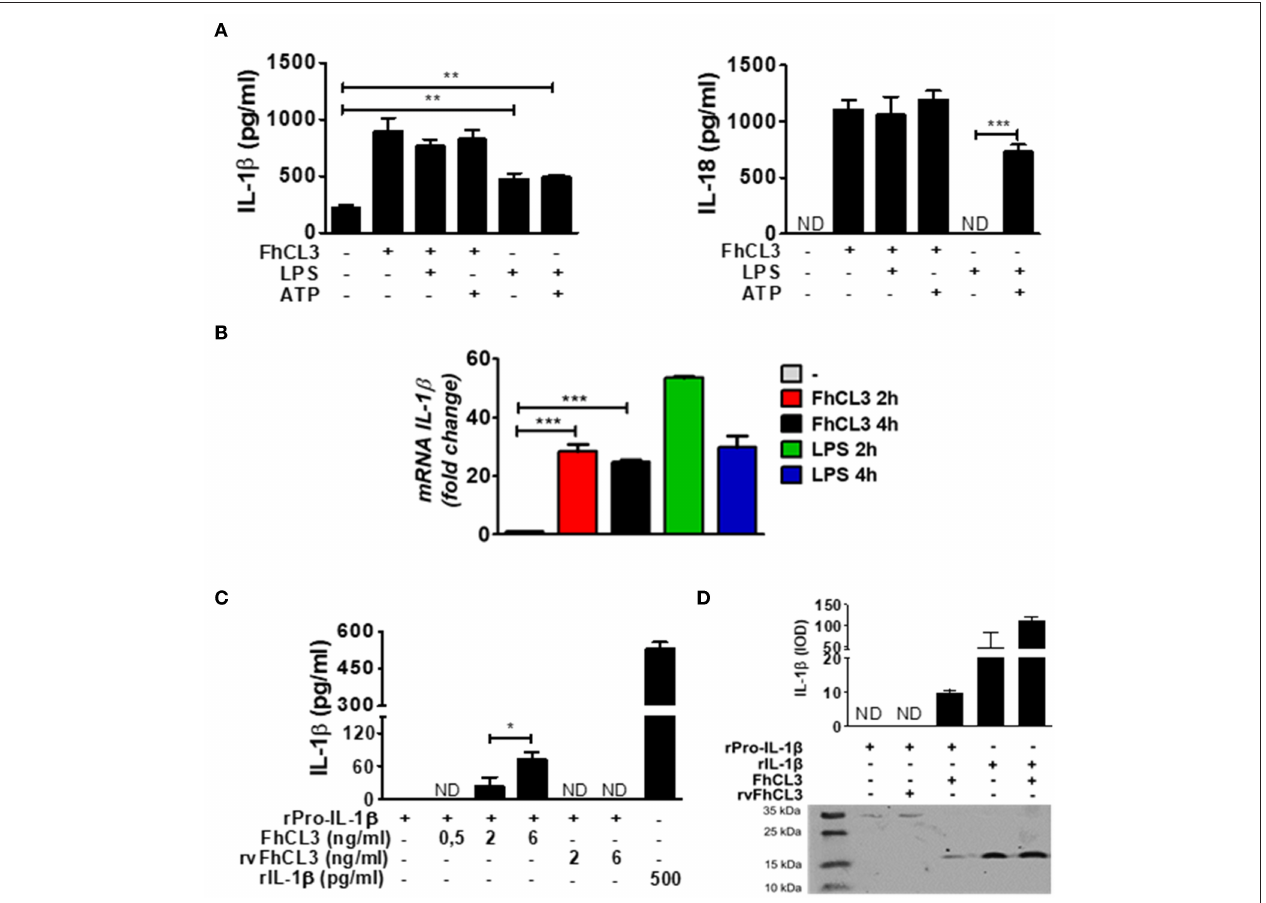
FIGURE 3 | FhCL3 promotes the expression, proteolysis and secretion of IL-1 β without LPS or ATP stimulation. (A) DCs were stimulated with medium, FhCL3 (10 µ g/mL) and/or LPS (100ng/mL) for 18h; in same cases ATP (5mM) was added the last 30min of culture. IL-1 β and IL-18 production were quantified by ELISA in culture supernatants. (B) DCs were treated with medium, FhCL3 (10 µ g/mL) and/or LPS (100ng/mL) for 2 or 4h. mRNA levels of IL-1 β were determined by q-PCR relative to the housekeeping gene β -actin and normalized to the level of unstimulated DCs. (C) Recombinant pro-IL-1 β (31 kDa) was incubated at 37 ◦ C in sodium phosphate buffer, with or without FhCL3 (0.5, 2 or 6ng/mL) or rvFhCL3 (2 or 6ng/mL) for 2h. Mature IL-1 β levels were determined in supernatants by capture ELISA. Recombinant IL-1 β (17 kDa) was used as positive control and represents the commonly detected mature form, whereas pro-IL-1 β indicates the inactive pro-form. (D) Western blot illustrating the cleavage of pro-IL-1 β by FhCL3 or rvFhCL3 (1 µ g/mL). Recombinant IL-1 β (17 kDa) or pro-IL-1 β (37 kDa) were loaded as controls. The graph bars show the densitometry analysis of IL-1 β (17 kDa) from two experiments with similar results. Bars panels show the mean ± SD and are representative of three or two independent experiments. ND, not detected; * p < 0.05; ** p < 0.01; *** p < 0.001 (ANOVA